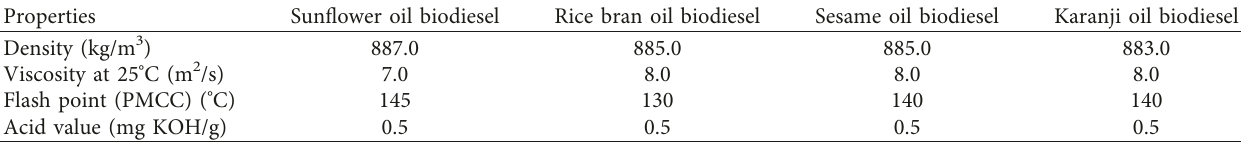
Table 1: Properties of biodiesel oils used as diluents.